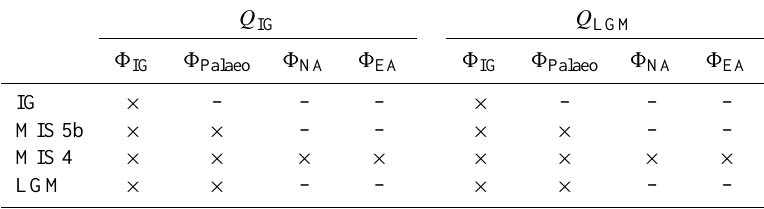
Table 2. Configuration of boundary conditions used in the study (marked by × ). The oceanic heat fluxes for interglacial and LGM conditions are denoted by Q IG and Q LGM and the interglacial and reconstructed palaeotopography by 8 IG and 8 Palaeo , respectively. The sensitivity tests of the palaeotopography with only the North American or Eurasian ice sheets present are denoted by 8 NA and 8 EA . Q IG × – – – × – – – MIS 5b × × – – × × – – MIS 4 × × × × × × × × LGM × × – – × × – –